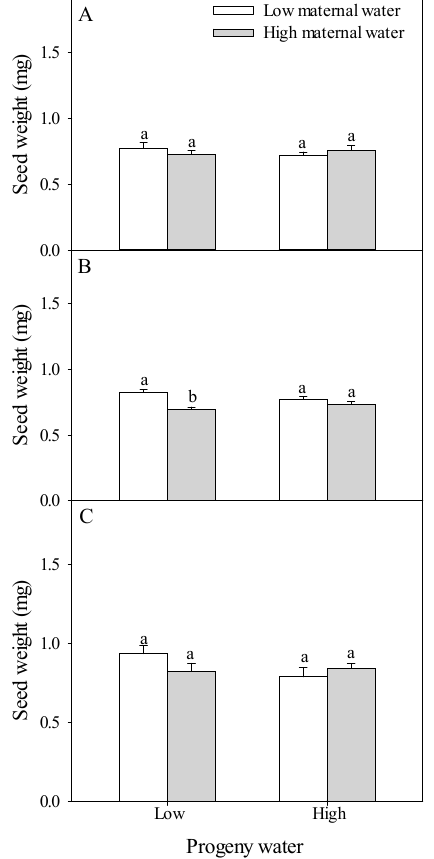
Figure 3. Effects of maternal and progeny water treatments on ( A ) seed weight of type A, ( B ) seed weight of type B, and ( C ) seed weight of type C. Different lowercase letters represent significantly different means between plants with different maternal water treatments under the same progeny water treatment according to t -test ( p < 0.05).